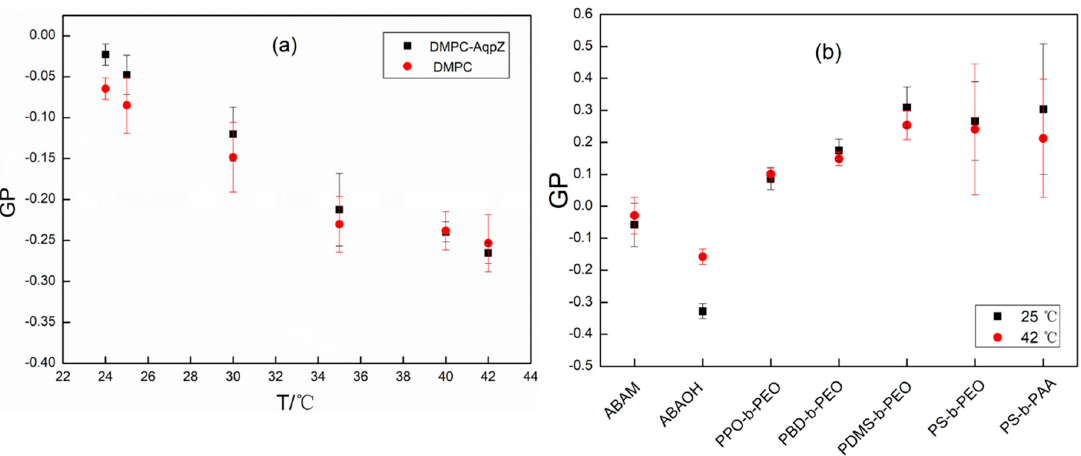
Figure 5. Generalized polarization (GP) for various vesicles assembled from lipid ( a ) and block polymers ( b ) at different temperatures.